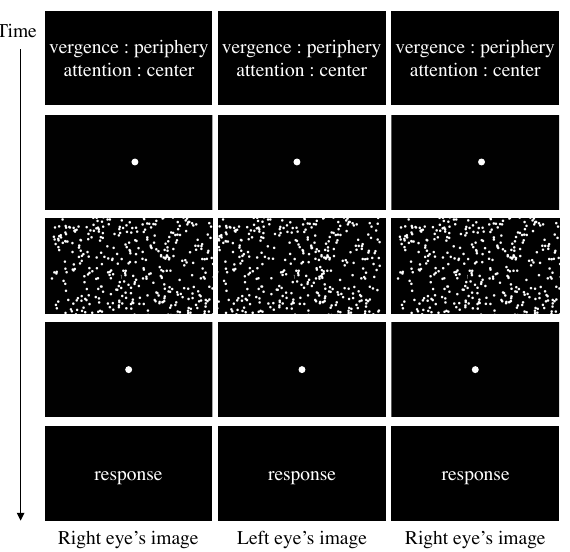
Figure 3. Time course of stimulus presentation in a trial: Left and center panels are for cross fusion, and center and right panels are for parallel fusion. By means of free-fusing, both cross and par- allel fusers can make an impression of the 3D structure of the stimulus. The observer attended to the motion stimulus while maintaining vergence at the different (or same) depth plane from attended plane on the anteroposterior axis at the center of stimu- lus.